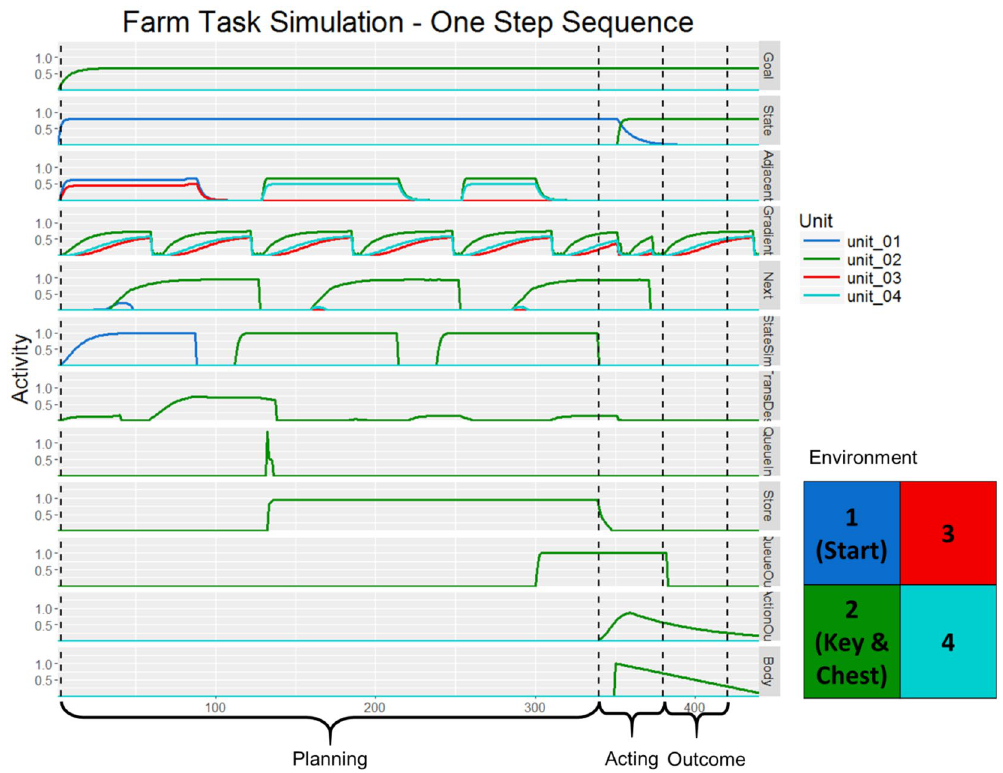
Figure 6. Model activity during a simulated one-step sequence of the Treasure Hunt task. The competitive queueing module first loads a plan and then executes it sequentially. State activity shows that the agent